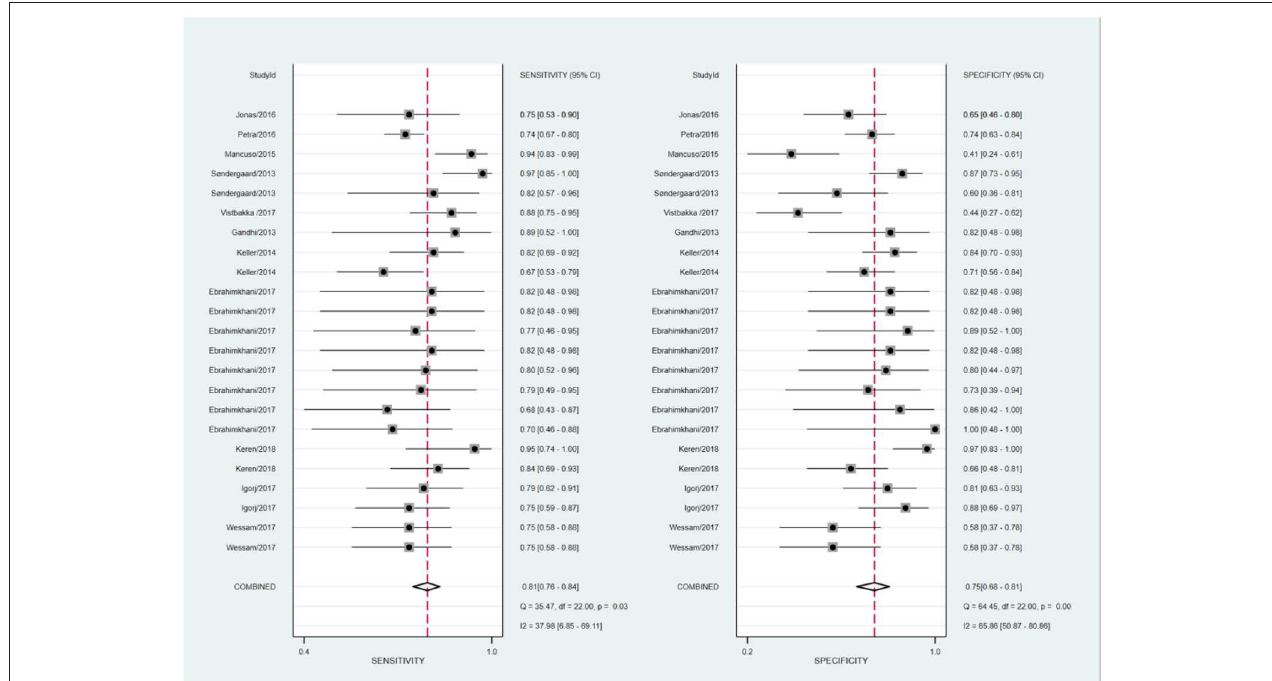
FIGURE 2 | Forest plots of sensitivity and specificity with corresponding heterogeneity